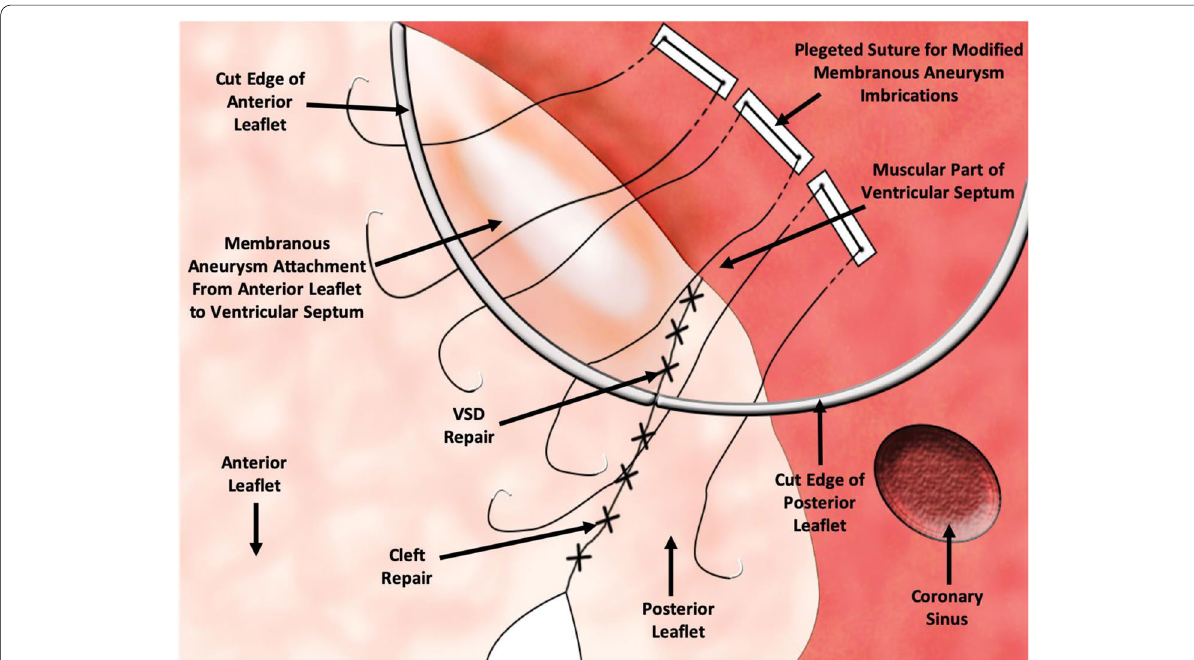
Fig. 3 Showing closing small VSD and cleft repair by sutures and aneurysmal protrusion obliteration by sutures. VSD: Ventricular Septal Defect